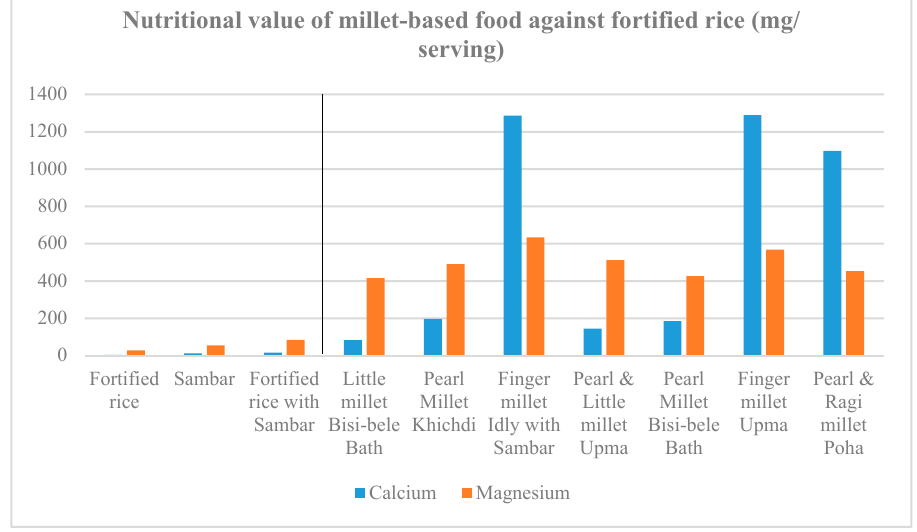
Figure 5. Calcium and magnesium content in the millet-based meal in comparison with a fortified rice-based meal. Table 7. Undernutrition indicators for the sampled children at baseline and end line by treatment status.